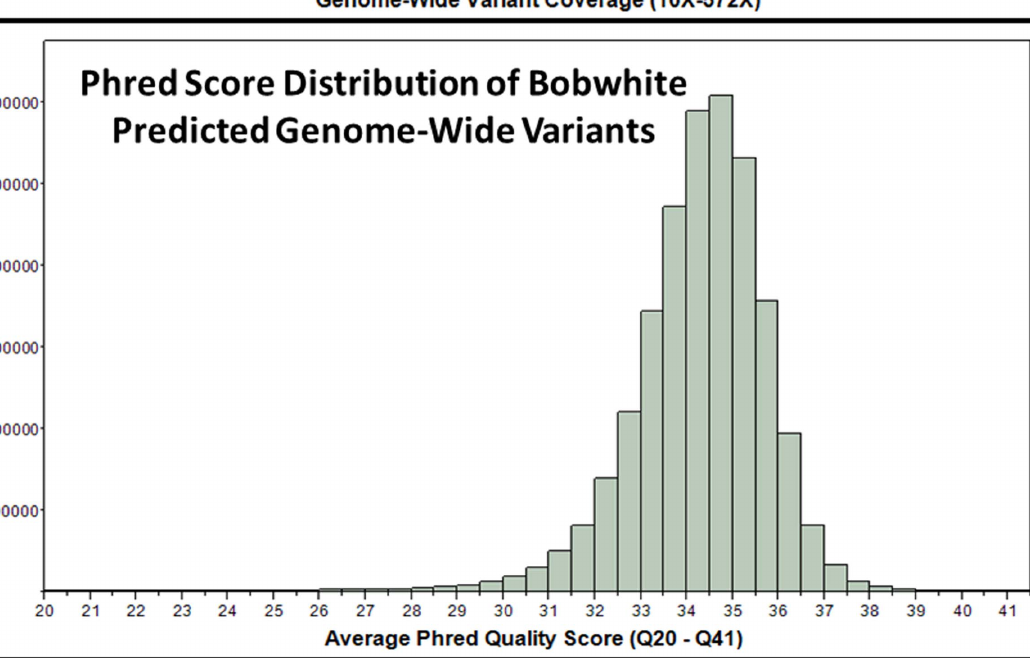
Figure 2. Autosomal Coverage and Quality Score Distributions for Variants Predicted in the Scaffolded Bobwhite ( Colinus virginianus ) Genome (NB1.1). Total genome-wide variants predicted within NB1.1 appears on the y-axis, with coverage and quality scores presented on the x-axis, respectively. Total variants include putative single nucleotide polymorphisms and small insertion deletion mutations ( # 5 bp) that were predicted within the repeat masked NB1.1 assembly.